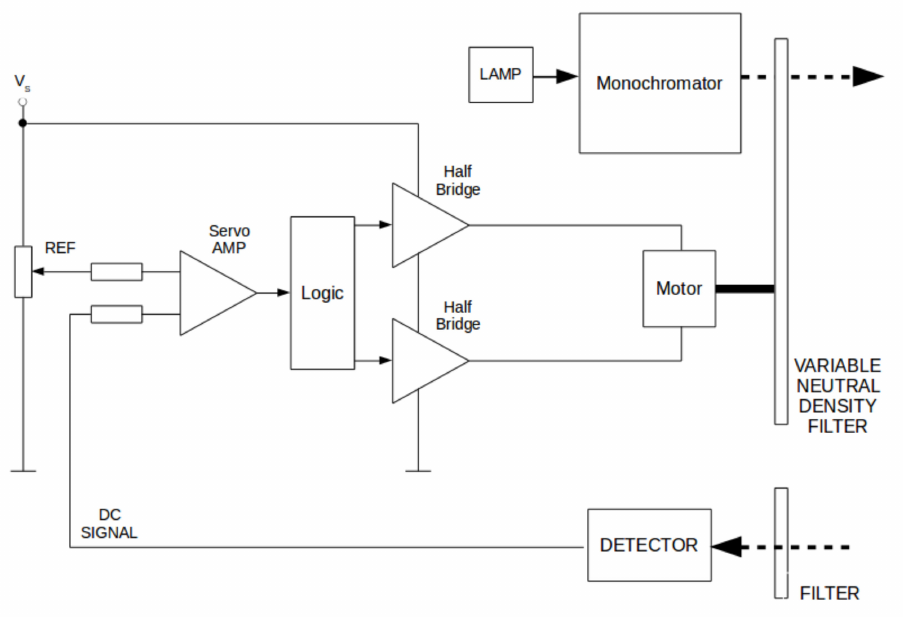
Figure 1. A block diagram showing the basic design of the analog servo-motor-based feedback